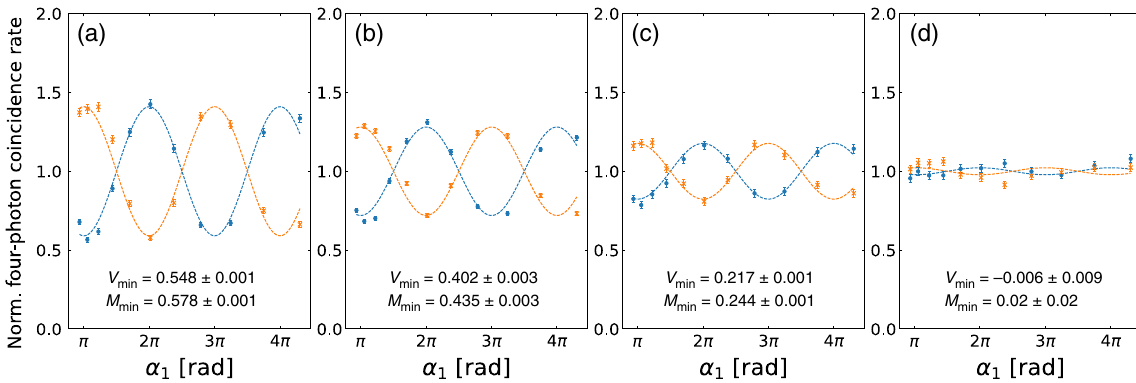
FIG. 4. Indistinguishability of photon A is reduced with respect to the others, by rotating its polarization using a half wave plate (with respect to the reference position θ ¼ 0 ° of the experiment in Fig. 3). (a) – (d) Measured four-photon interference fringe when photon A is made increasingly distinguishable, by rotating the half wave plate respectively by θ ¼ 11 °, θ ¼ 19 °, θ ¼ 31 °, θ ¼ 45 °. The ð a Þ ð b Þ ð c Þ ð d Þ visibility of the interference fringe decreases, as the minimum measured two-photon Hong-Ou-Mandel interference visibility (extracted ( M ) decreases. The measured four-photon interference fringe contrast drops to almost zero single-photon indistinguishability) V min min when photon A is almost fully